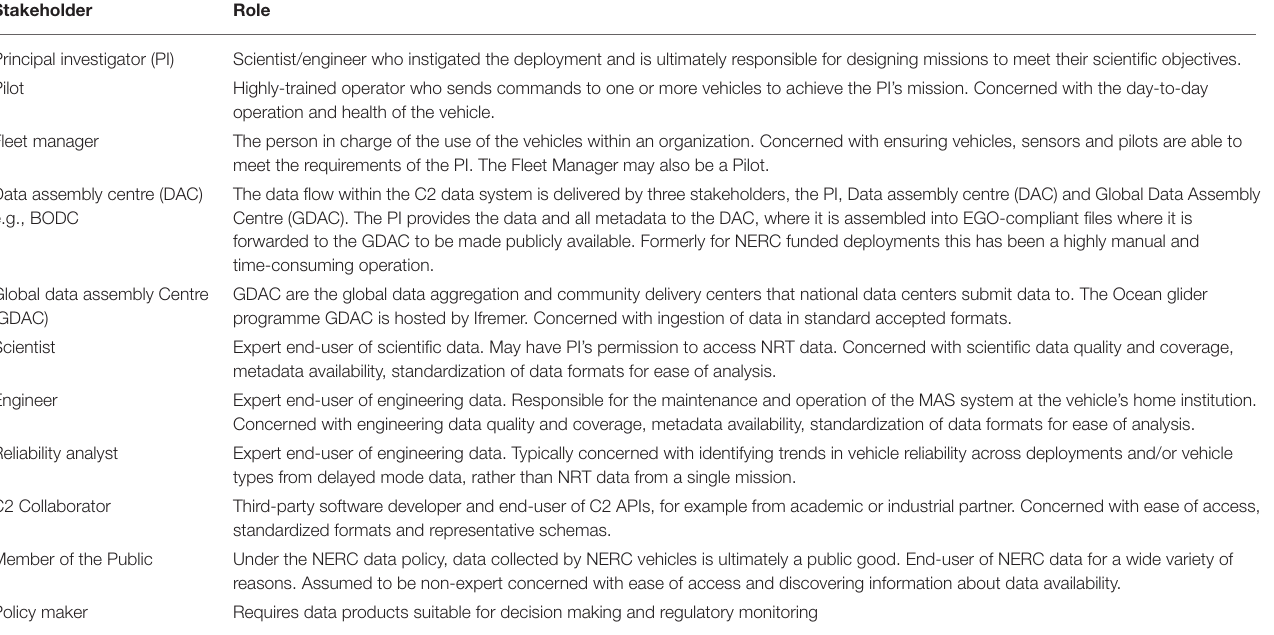
TABLE 1 | Key users of the oceanids